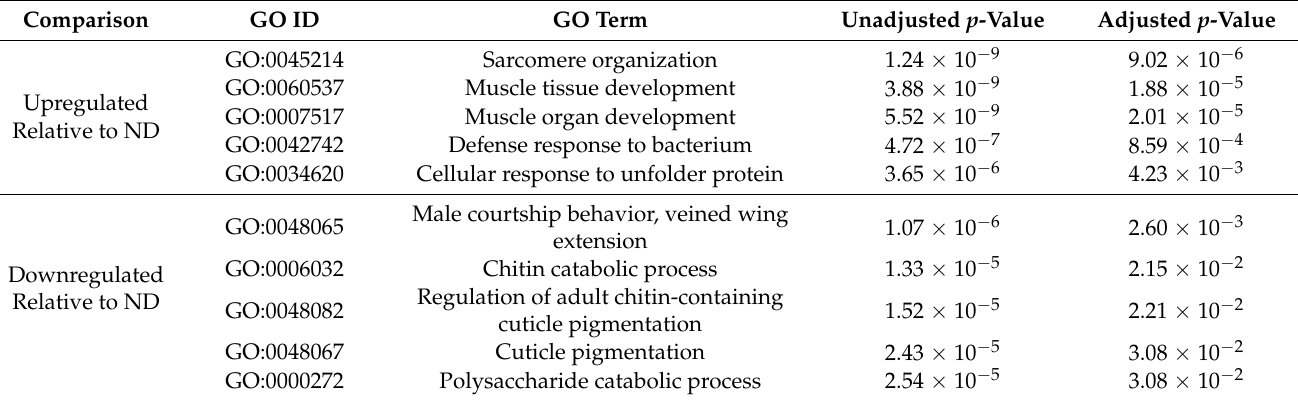
Table 6. Summary of the GO biological processes that are involved in LD. The table shows GO terms that are significantly enriched among transcripts that are either up- or downregulated during LD relative to ND. The top five up and down enriched GO terms for this comparison are shown. Redundant GO terms were removed using semantic clustering with REVIGO. GO terms that are enriched in the MD vs. LD comparison are shown in Table 4, and a complete list of enriched GO terms can be found in Supplementary Table S2.